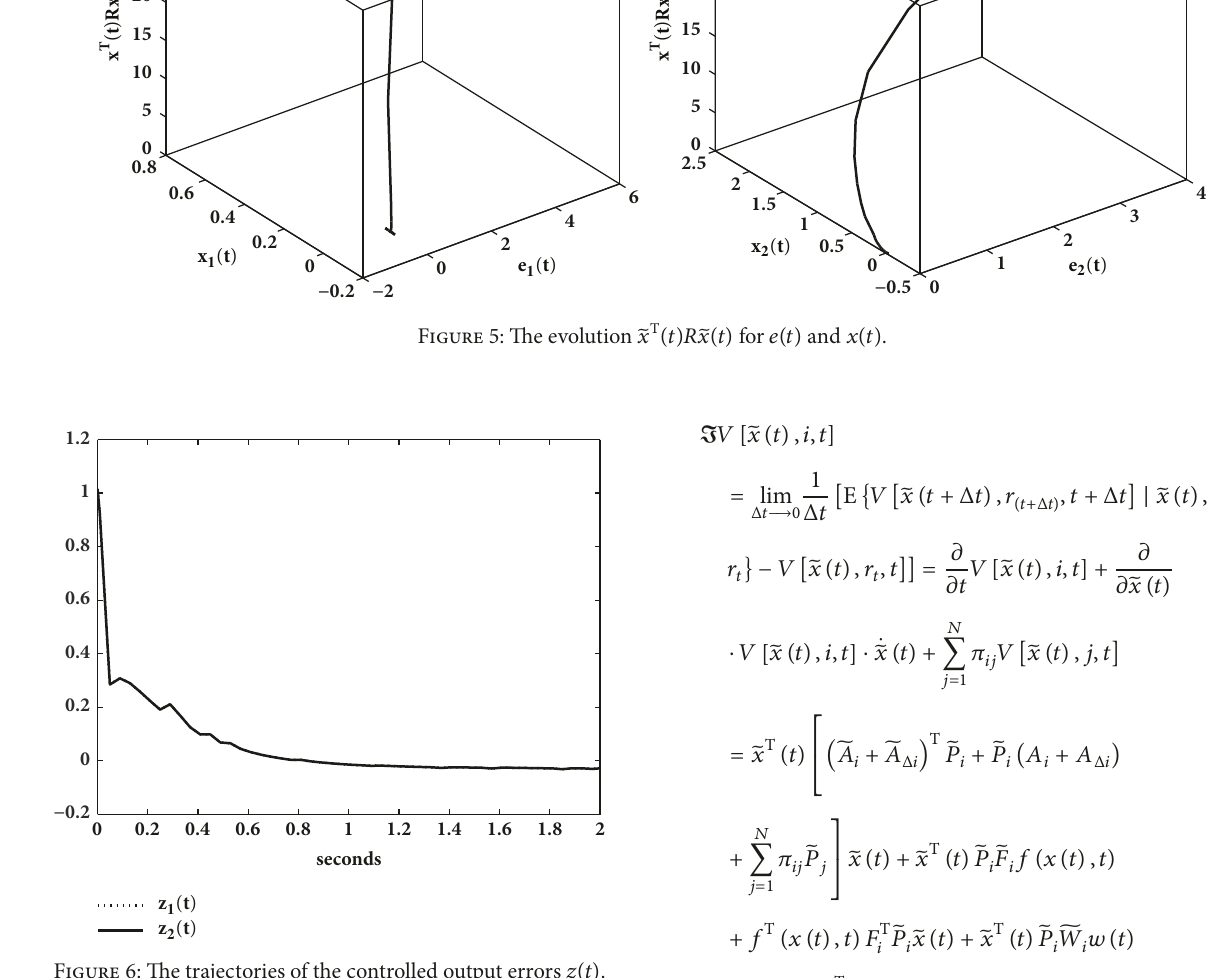
Figure 6: The trajectories of the controlled output errors 𝑧(𝑡) .